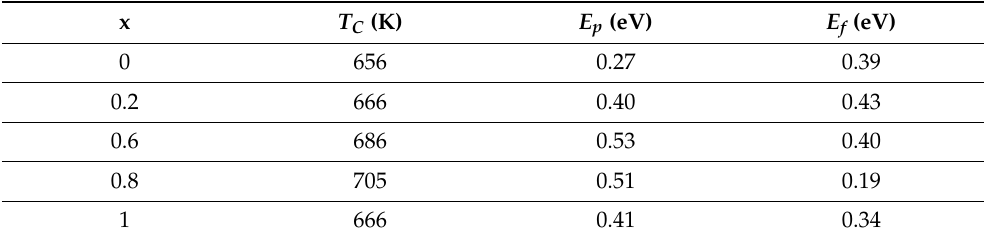
Table 8. The Curie temperature ( T C ) determined from the DC electrical resistivity data and the activation energy for ferrimagnetic ( E f ) and paramagnetic ( E P ) of Ni + 2 0.8, and